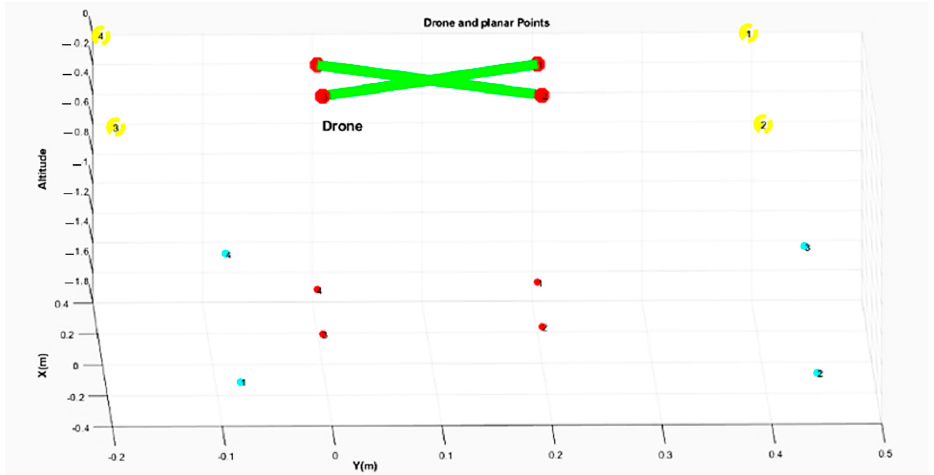
Figure 11. Estimation of the real-world 3D points in the camera frame.